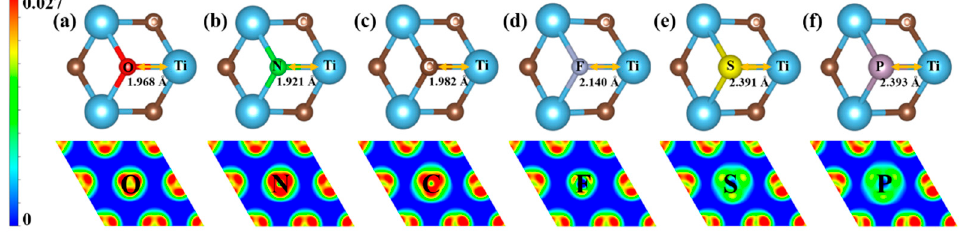
Figure 6. Bond length and the electron density difference. ( a ) Top image shows the local crystal structure and the O-H bond length of 2D Ti 3 C 2 O 2 , the bottom image shows the electron density difference of 2D Ti 3 C 2 O 2 ; ( b – f ) top image shows the local crystal structure and the NM-H bond length of 2D NM-Ti 3 C 2 O 2 , the bottom image shows the electron density difference of 2D NM-Ti 3 C 2 O 2 . Warm color means gaining electrons, cold color means losing electrons.